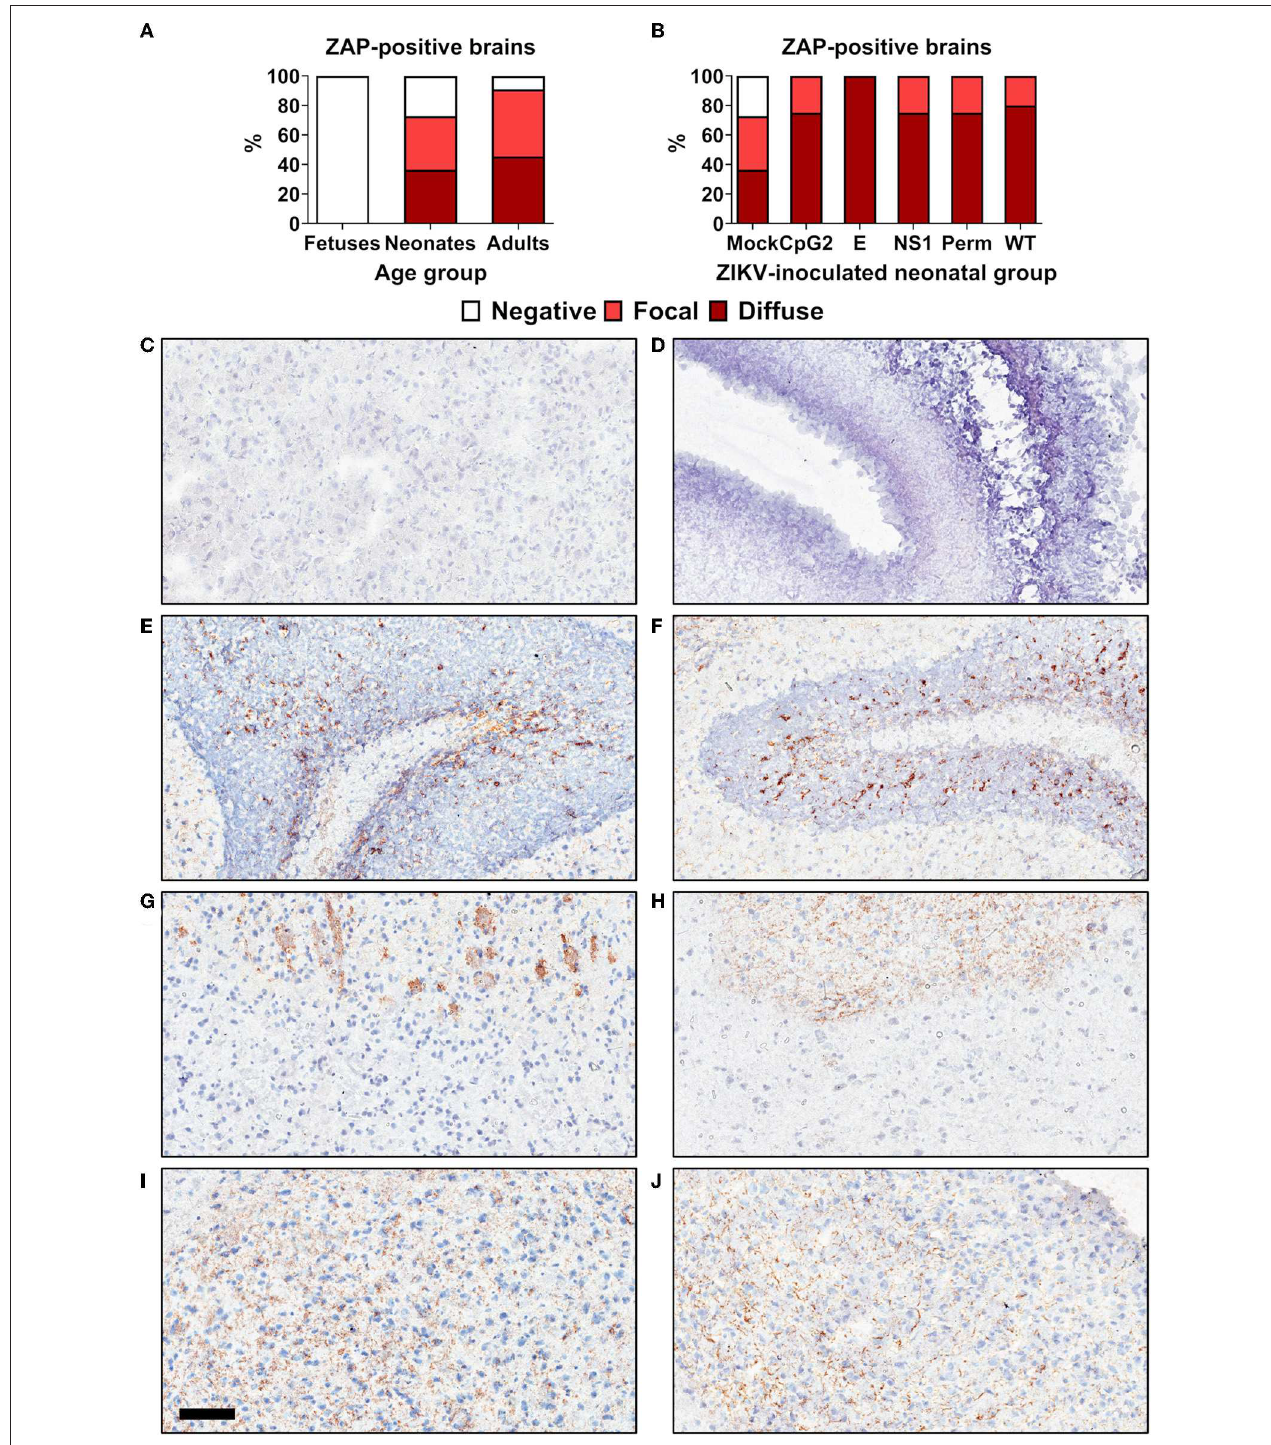
FIGURE 8 | Age-dependent ZAP expression in brain tissues of mice. (A) ZAP expression in different age groups ( n = 8–11 healthy animals). (B) ZAP expression in neonatal mouse groups inoculated with different ZIKV variants at 1 day and sampled at 21 days after birth ( n = 4–11). (C) Negative staining control. (D) Fetal brain. (E) Neonatal cerebellum. (F) Adult cerebellum. Focal staining in neonatal (G) and adult (H) white matter. Diffuse staining in neonatal (I) and adult (J) white matter. The scale bar is 100 µ m.